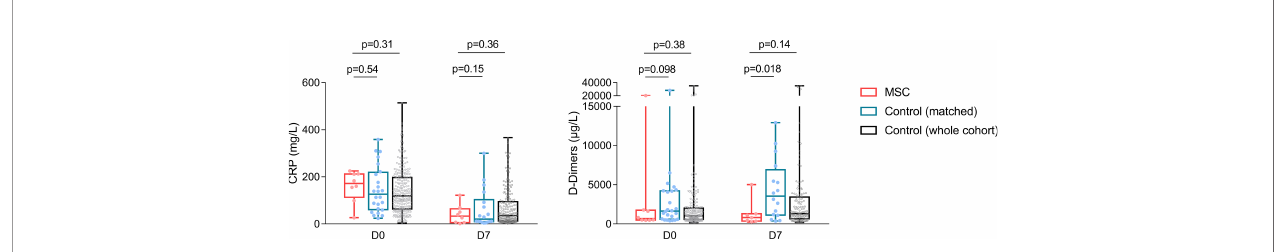
FIGURE 3 | Day-0 and day-7 CRP and D-dimer values in the MSC and control groups. Boxes extend from the 25th to 75th percentiles, and the line in the box is plotted at the median, while whiskers represent minimum and maximum, and points represent